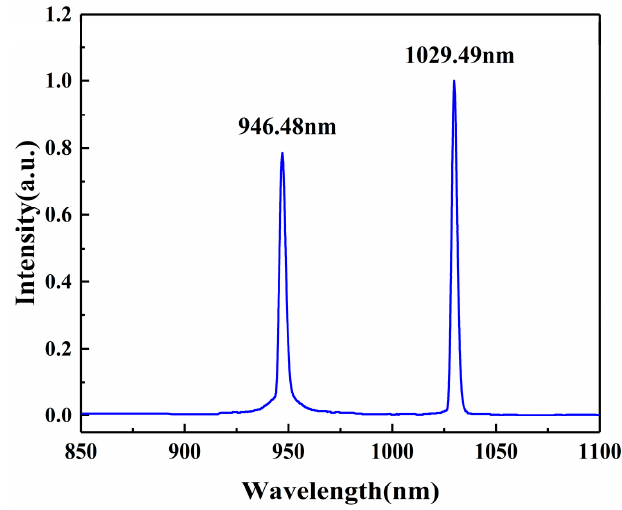
Figure 6. The spectrogram of the dual-wavelength laser.